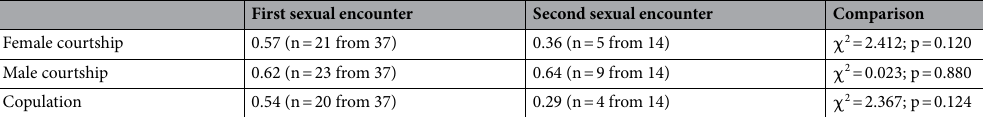
Table 1. Courtship and copulation proportions during first and second sexual encounters, with the corresponding results of the statistical comparisons between the two